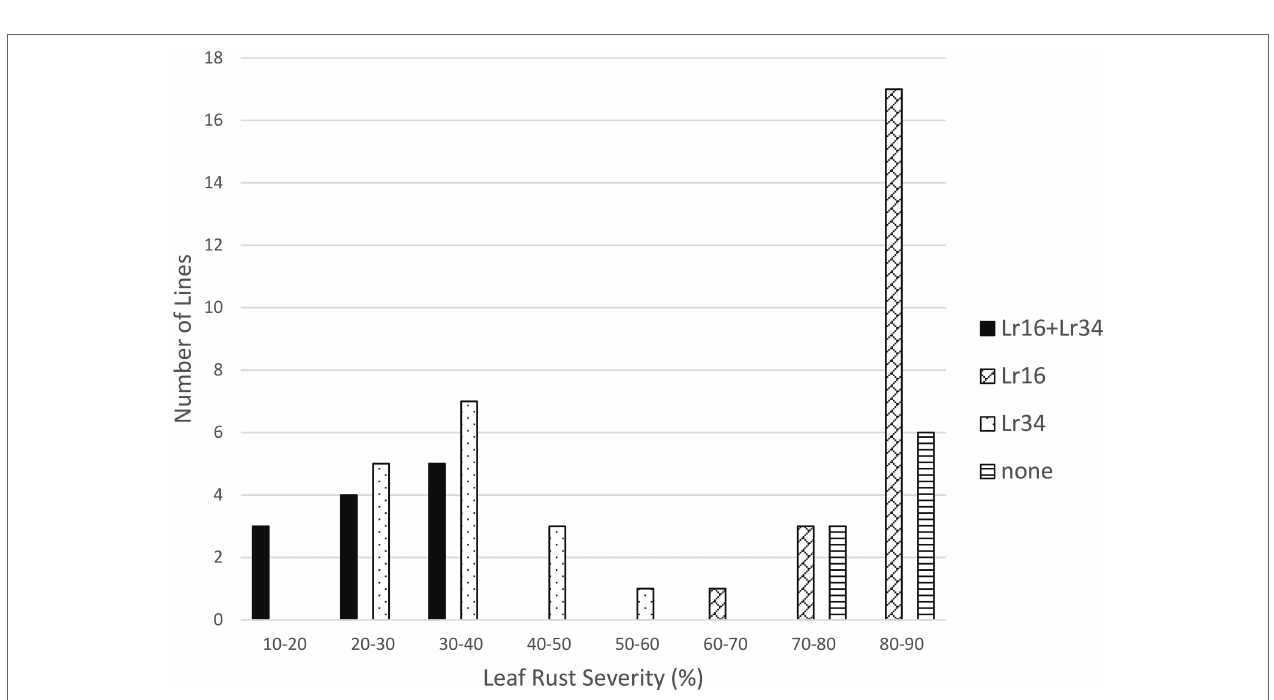
FIGURE 3 | Average leaf rust field severity (2012–2015) for progeny lines from the cross Lr16 /